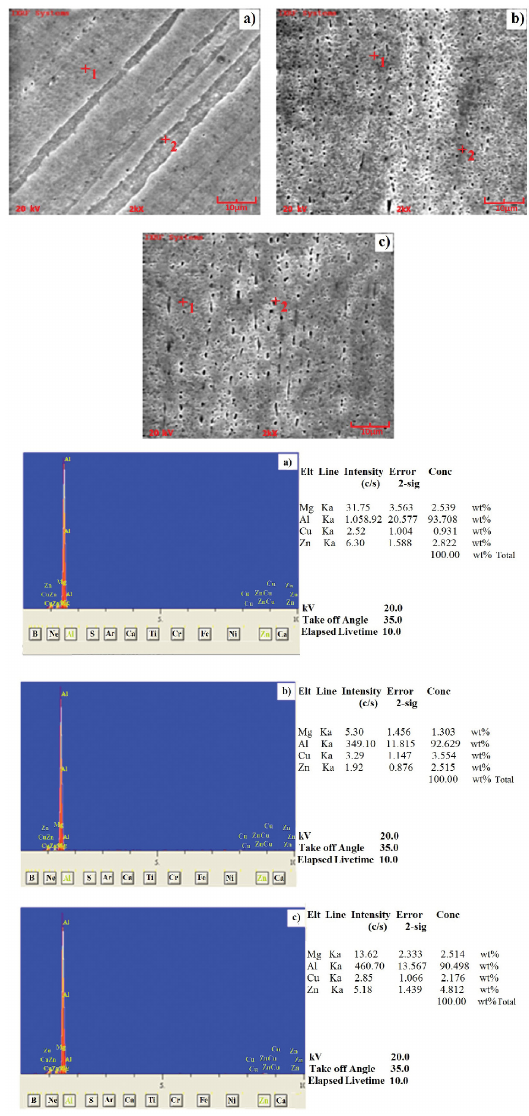
Figure 7. Stress-strain diagram of samples aged at 140 °C temperature for different ageing times; a) SHTWQ b) SHTSQ.